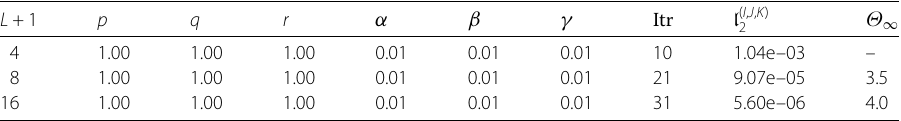
Table 5b Errors and order for UM-FOCS in Example 5.5 at (cid:2) = 0.1